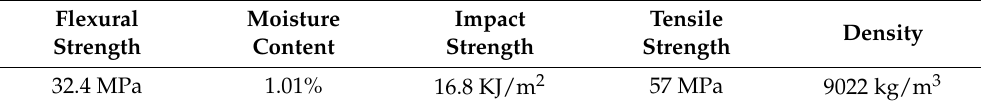
Table 1. Properties of the workpieces.